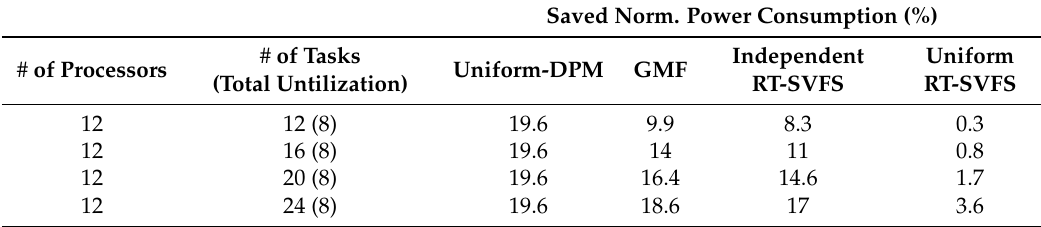
Table 14. Summary of the experimental results by varying the number of tasks.